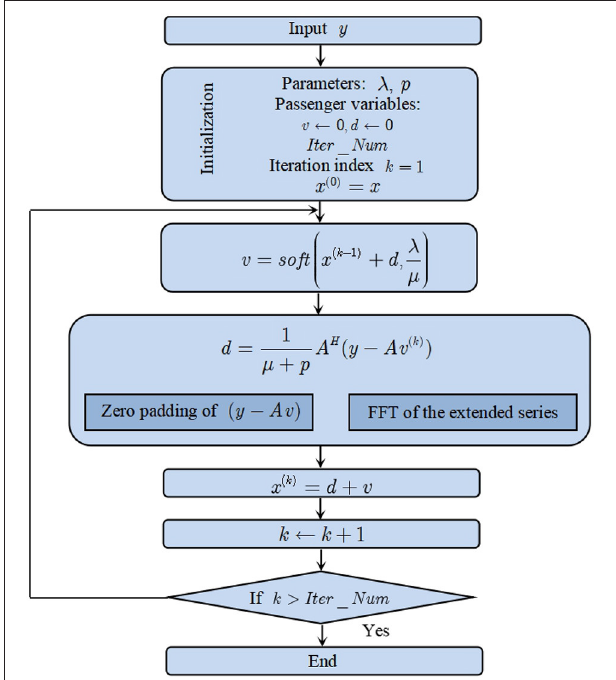
FIGURE 1 | Flow chart of the proposed ASD